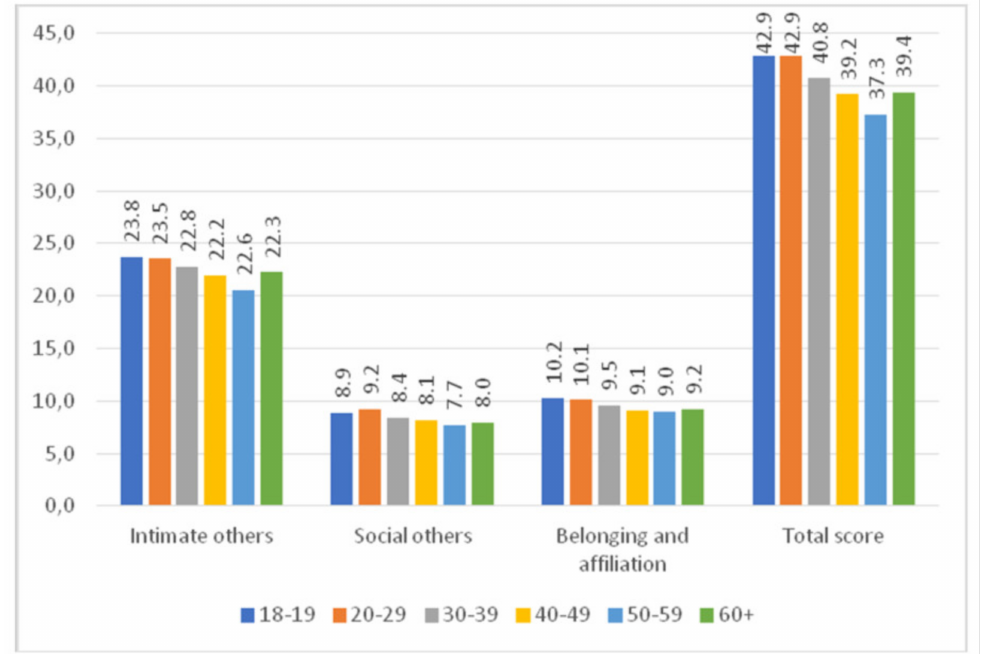
Figure 4. R-UCLA score and the age of